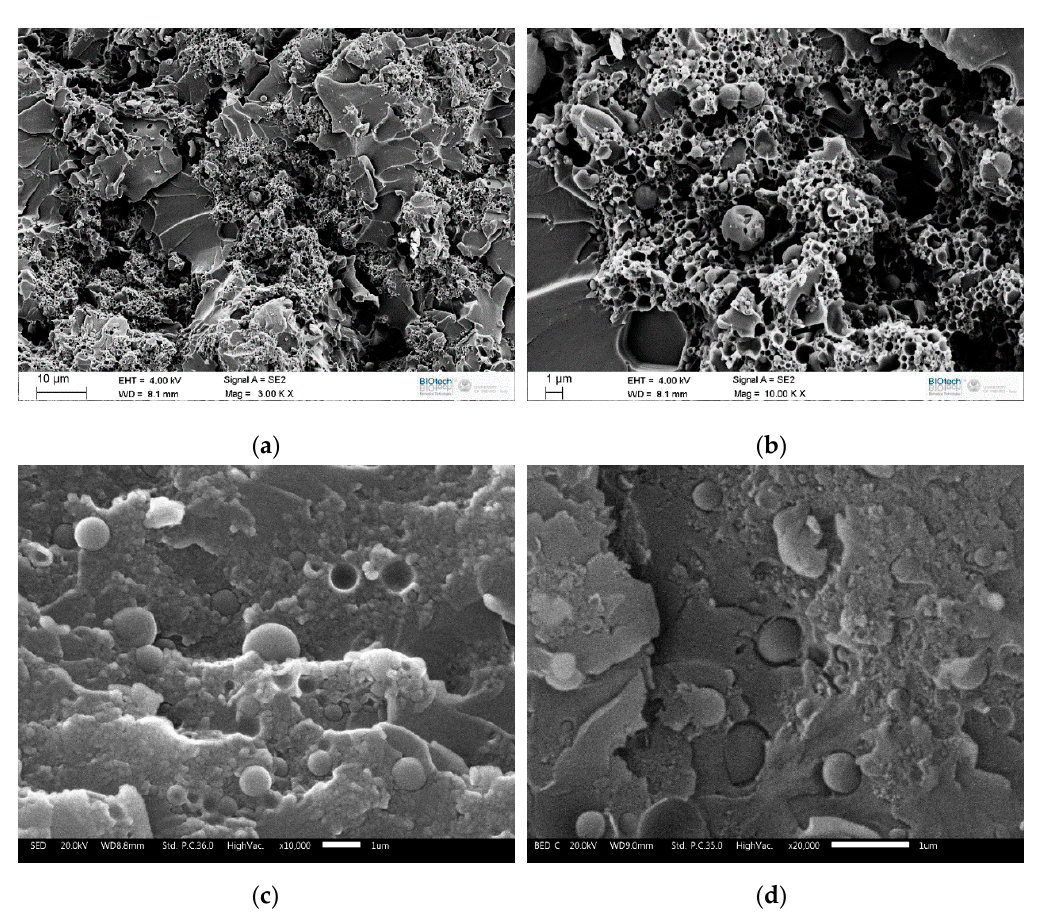
Figure 8. SEM micrographs of the samples EP-MC2 ( a , b ) and EP-MC2-CF ( c , d ).